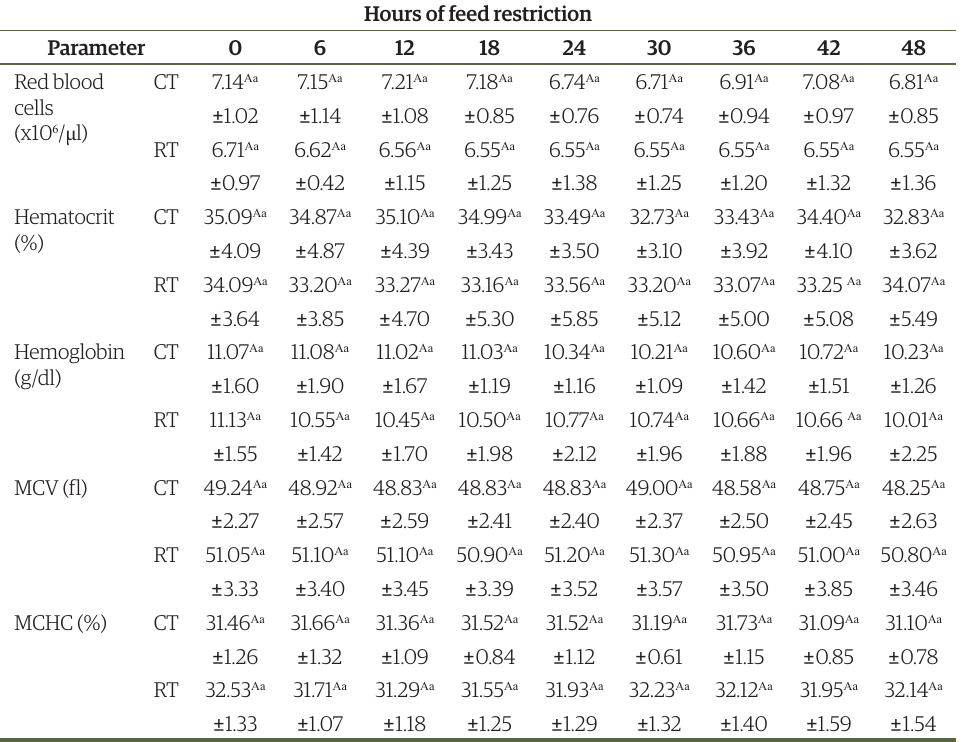
SD of hematological parameters of horses during feed restriction (RT) for 48 h and in control Table 2. Mean horses ±